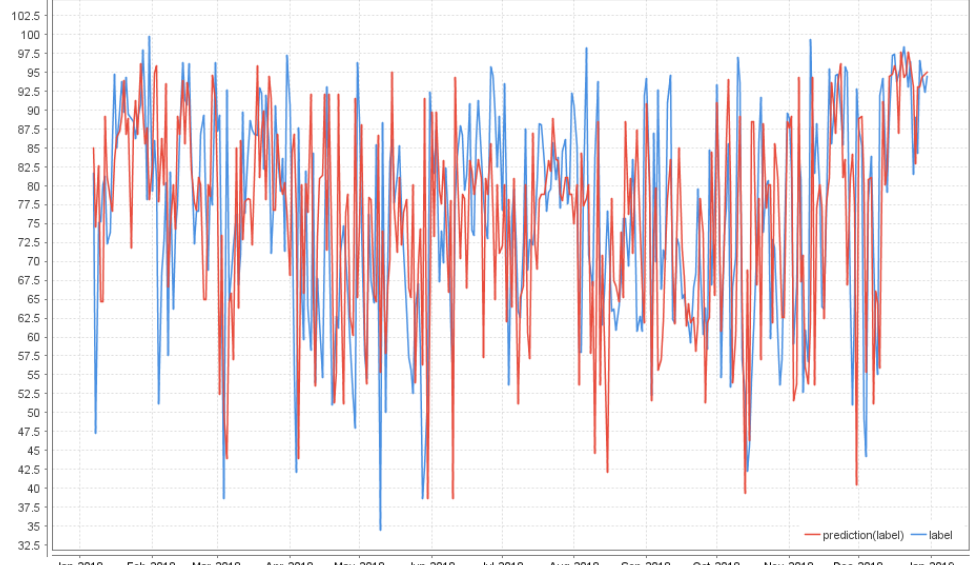
Figure 9. Decision Tree (DT) prediction overview for Sarmasu: CADM + CDM 3 sources scenario: the values for the actual value, in blue, and predicted value, in red ( X -axis) and the time series for which the results were registered ( Y